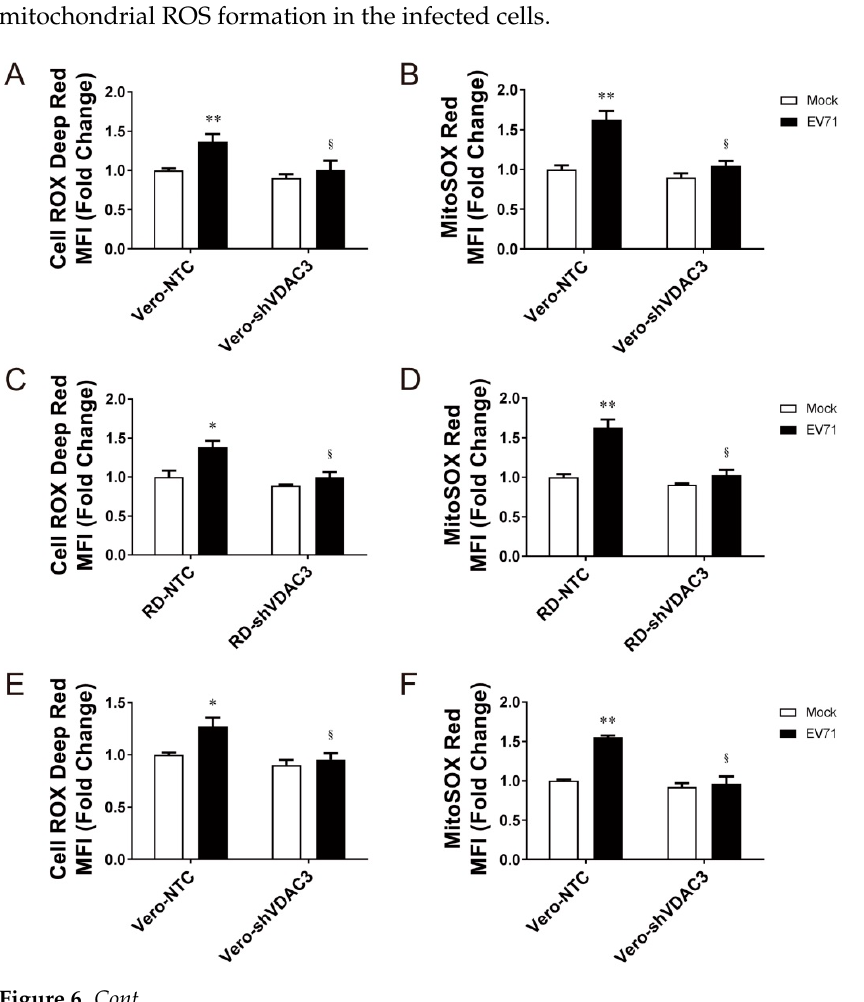
Figure 6. VDAC3 is essential to mitochondrial ROS generation. ( A – D ) Vero ‐ shVDAC3 and Vero ‐ NTC cells ( A , B ) were mock infected or infected with EV71 virus at an MOI of 1.25. RD ‐ shVDAC3, and RD ‐ NTC cells ( C , D ) were mock infected or infected with EV71 virus at an MOI of 0.01. Twen ‐ ty ‐ four hours later, the cells were stained with CellROX Deep Red ( A , C ) for quantification of total cellular ROS, or with MitoSOX Red ( B , D ) for quantification of mitochondrial ROS. ( E – H ) Vero ‐ shVDAC3 and Vero ‐ NTC cells ( E , F ), or RD ‐ shVDAC3 and RD ‐ NTC cells ( G , H ) were mock infect ‐ ed or infected with EV71 virus at an MOI of 10. Six hours later, the cells were stained with CellROX Deep Red ( E , G ) for quantification of total cellular ROS or with MitoSOX Red ( F , H ) for quantification of mitochondrial ROS. The MFI is expressed as fold change relative to that of mock ‐ infected NTC cells. The results are mean ± SD, n = 6. * p < 0.05, ** p < 0.01 vs. mock ‐ infected NTC cells; § p <0.05 vs. infected NTC cells.